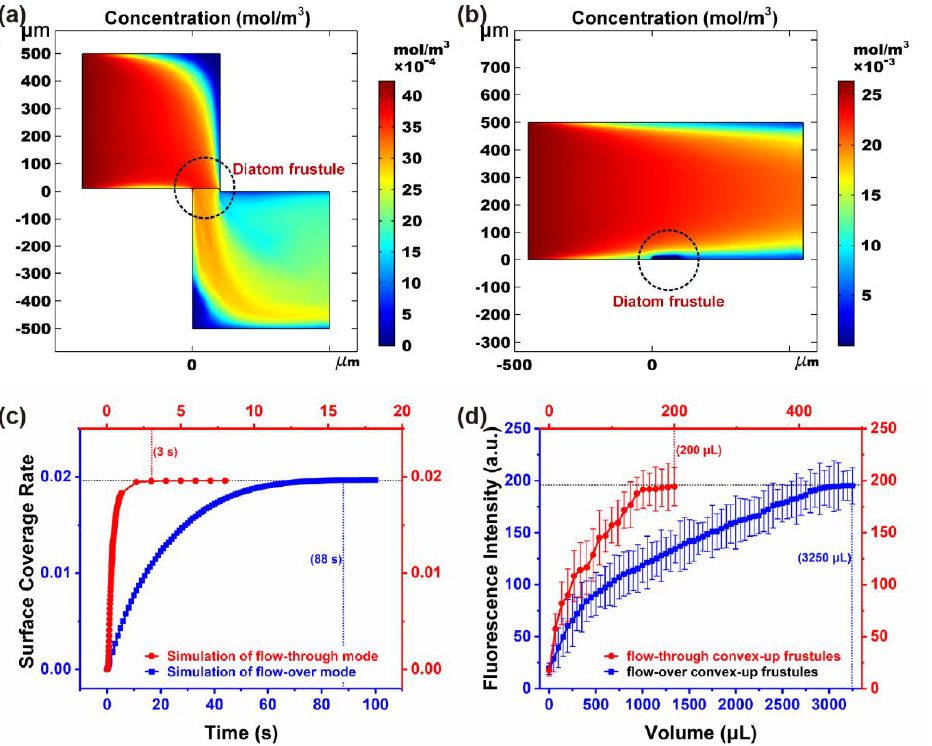
Figure 7. Simulation results of concentration distribution of ( a ) flow-through, ( b ) flow-over detection, and ( c ) surface coverage rate of fluorescence molecules over time. ( d ) Smartphone analysis results of fluorescence intensity of flow-through and flow-over for convex-up frustules.